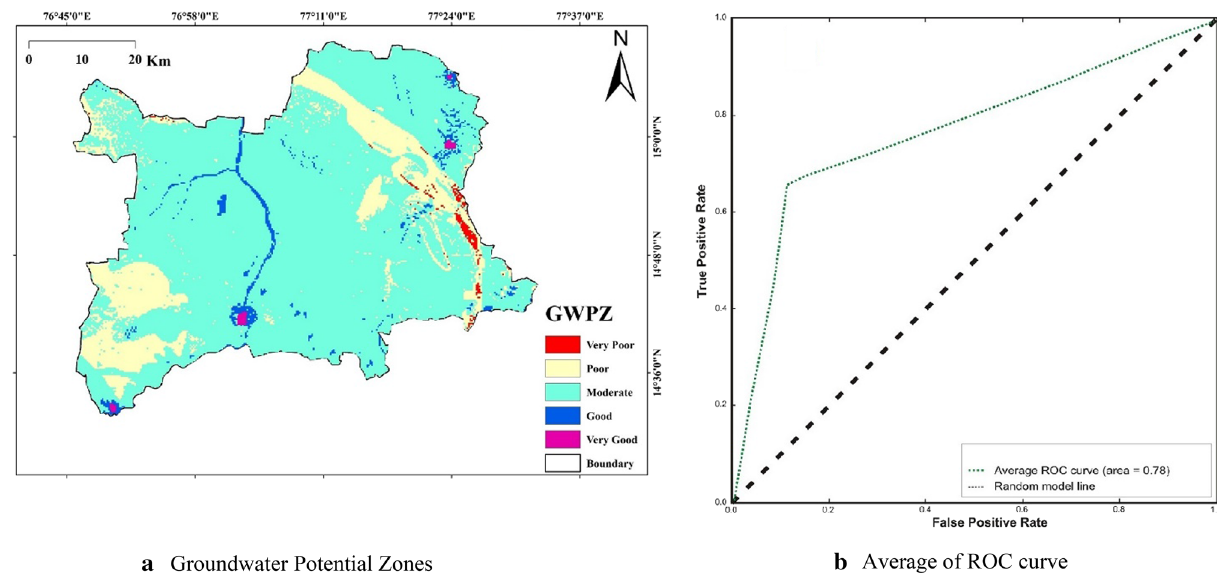
Fig. 11 a Groundwater potential zones and b average of ROC